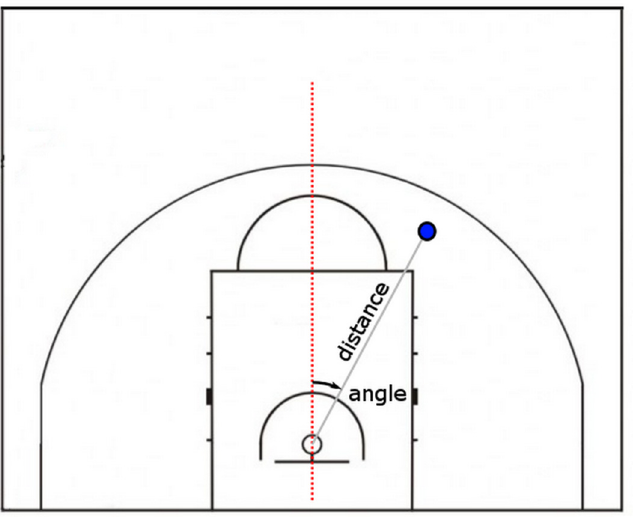
Fig 1. A diagram of how we decomposed shot location into distance and angle. The blue dot represents the location of the basketball shot.